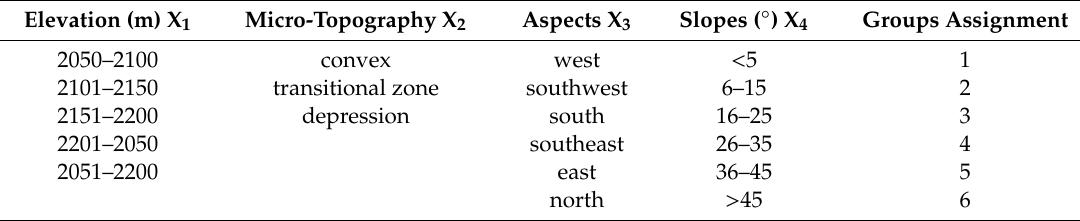
Table 6. Standardization of di ff erent environmental